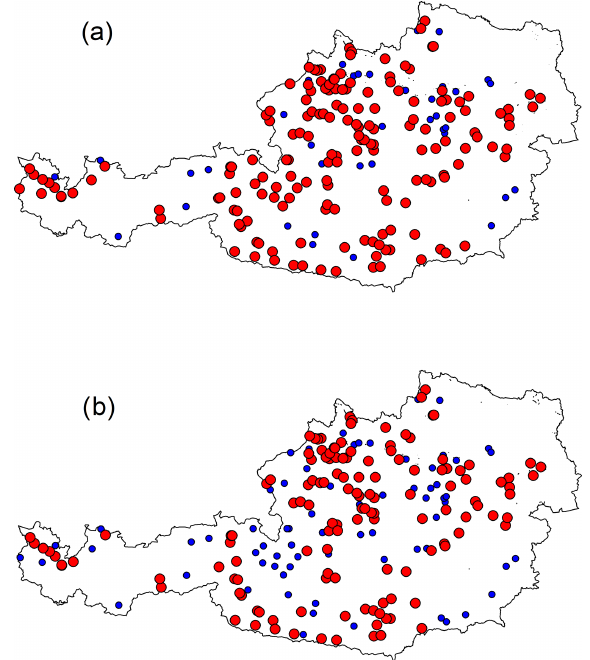
Figure 8. (a) Red dots (170) refer to catchments with at least one upstream- or downstream-nested gauged catchment (Criterion 1). (b) Red dots (137) refer to catchments with at least one nested gauged catchment sharing more than 10% of the drainage area (Cri- terion